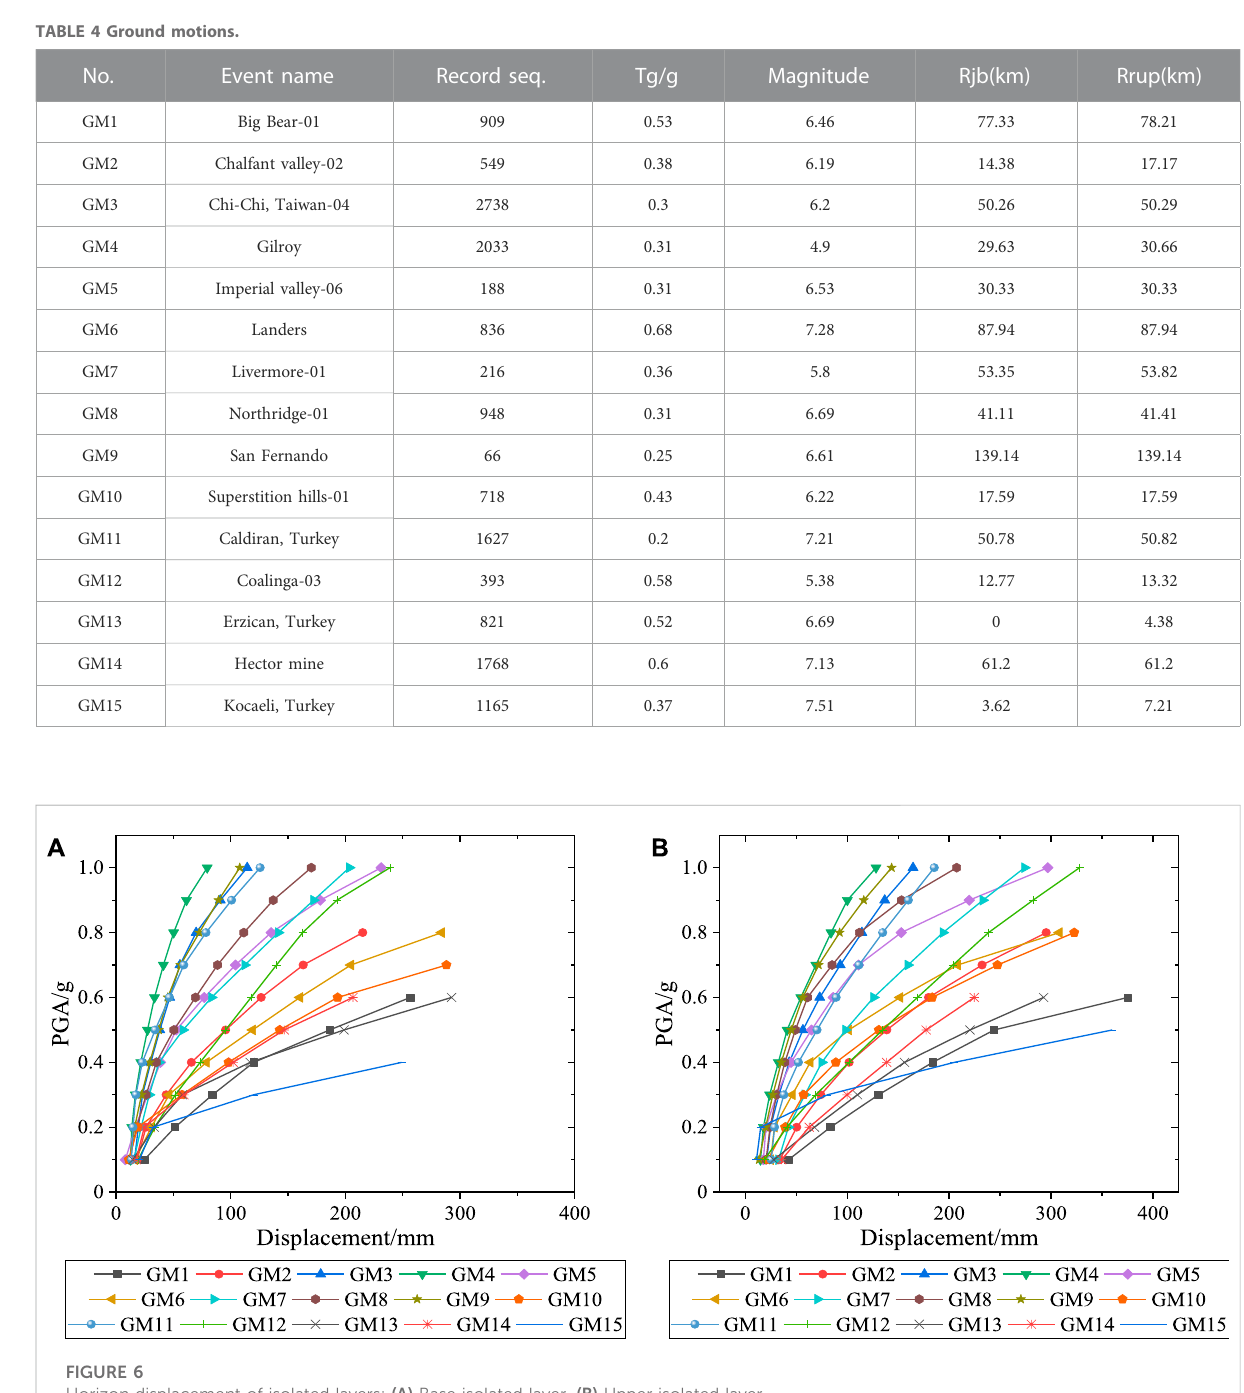
ground motions. As the ground motion PGA increases, tensile stress will arise in some bearings of the isolated layer, and there is a risk of overturning and collapse of the structure. Comparing the IDA curve of maximum vertical stress of the base isolated layer and the upper isolated layer reveals that tensile stress and tensile